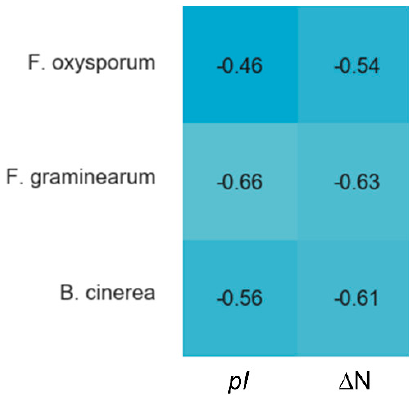
Figure 2. Correlations between the overall charge or pI and antifungal activity of plant defensins. The heat map shows Pearson coefficients calculated in Spyder using a built-in Pandas correlation function for F. oxysporum, F. graminearum, and B. cinerea. The overall charge is represented as the difference between positively (Arg, Lys) and negatively (Asp, Glu) charged residues, Δ N. The blue color indicates a negative correlation, e.g., a defensin active at smaller concentrations (IC50). Lighter shades of blue correspond to stronger correlations. Coefficients from -0.50 to -0.70 are classified as a moderate correlation, yet the trend is present. Table 1. Inhibitory concentrations for plant defensins against F. oxysporum , F. graminearum , and B. cinerea . Defensin